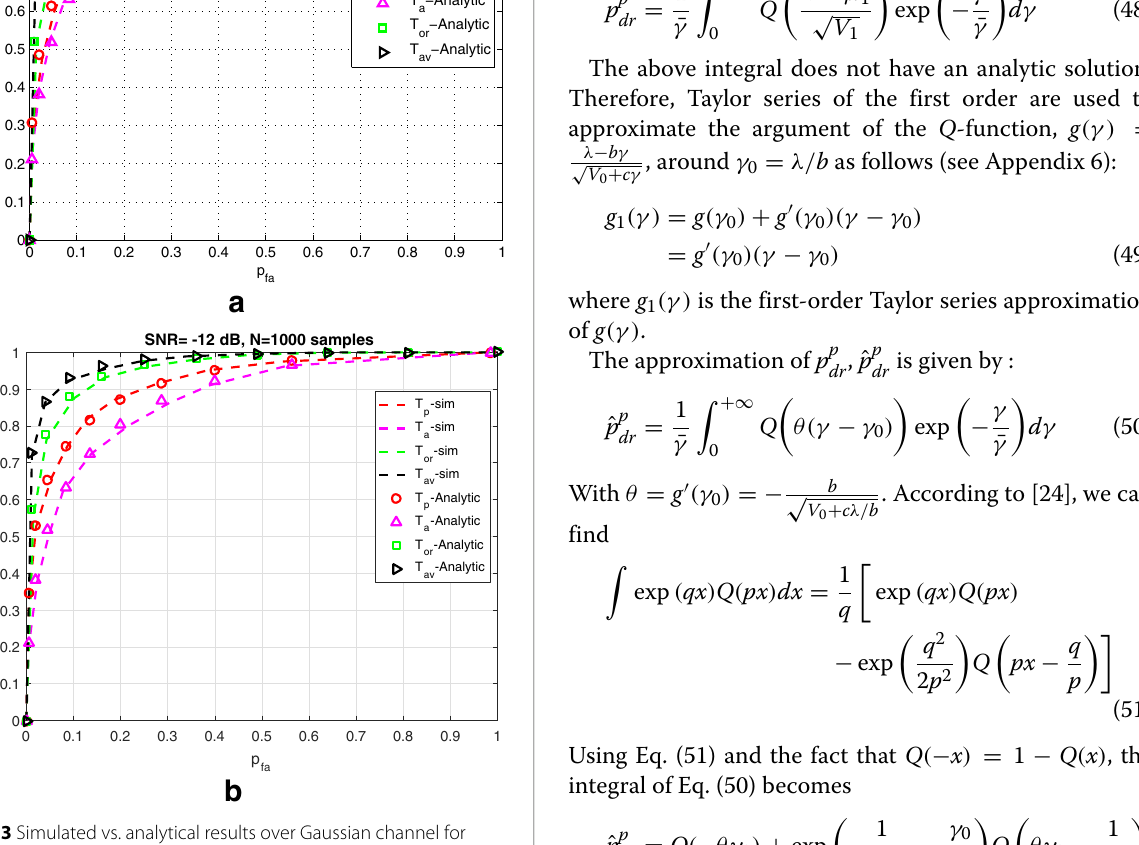
Fig. 3 Simulated vs. analytical results over Gaussian channel for rectangular and raised-cosine pulse-shaping filters. a Rectangular pulse-shapingfilter. b